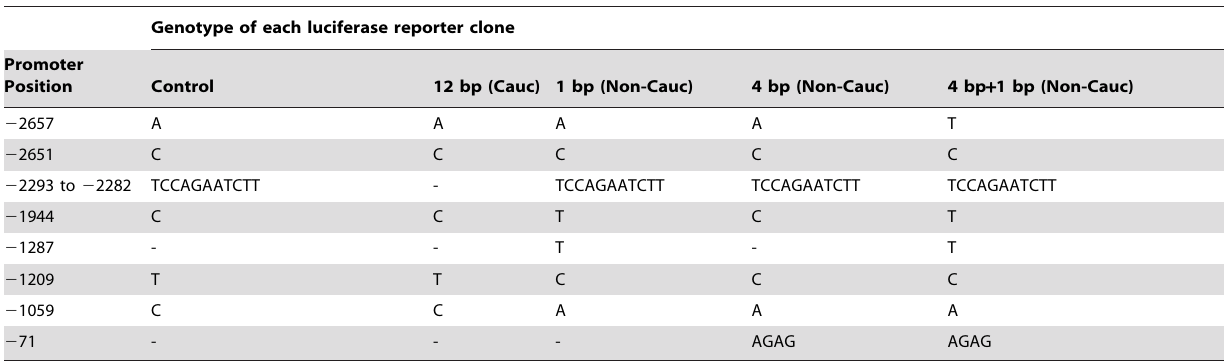
Table 6. Sequences of BEEC patients and controls sub-cloned into the pGL3 luciferase